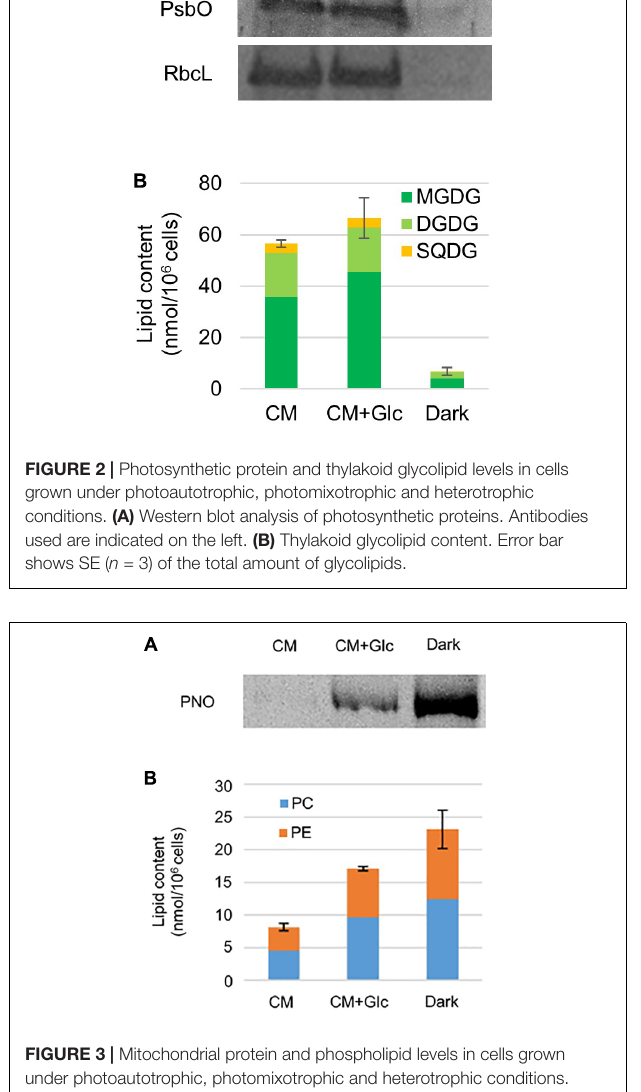
FIGURE 3 | Mitochondrial protein and phospholipid levels in cells grown under photoautotrophic, photomixotrophic and heterotrophic conditions. (A) Western blot analysis of a mitochondrion protein, PNO. (B) Phospholipid content. Error bar shows SE ( n = 3) of total amount of two extraplastidic phospholipids, PC and PE.